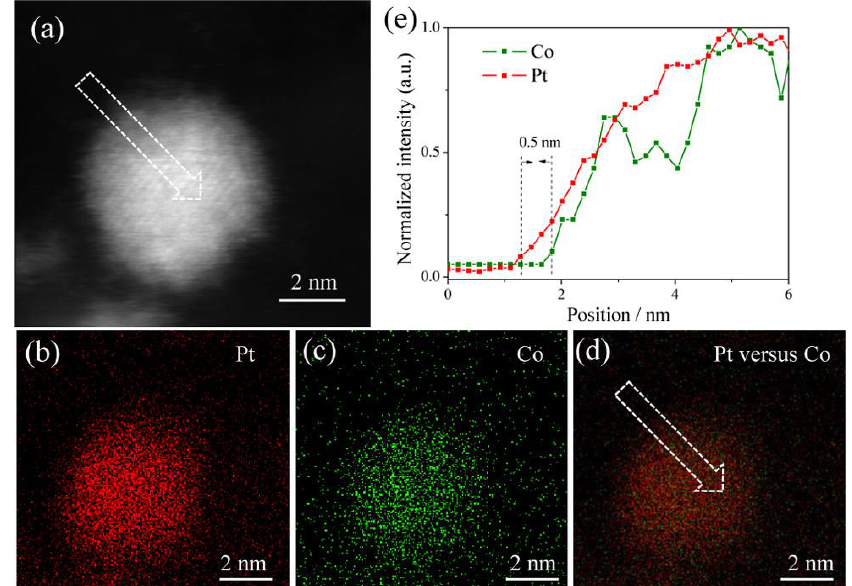
Figure 3. Pt-rich PtCo NPs with Pt-rich shells: ( a ) ADF-STEM image of a Pt 3 Co@Pt NPs. ( b – d ) EELS mapping of Pt (red), Co (green), and the composite image of Pt vs. Co. ( e ) Line-profile analysis from the indicated area of ( a , d ), demonstrating about 0.5 nm Pt skin thickness. Reproduced from [49], with permission from American Chemical Society, 2016.